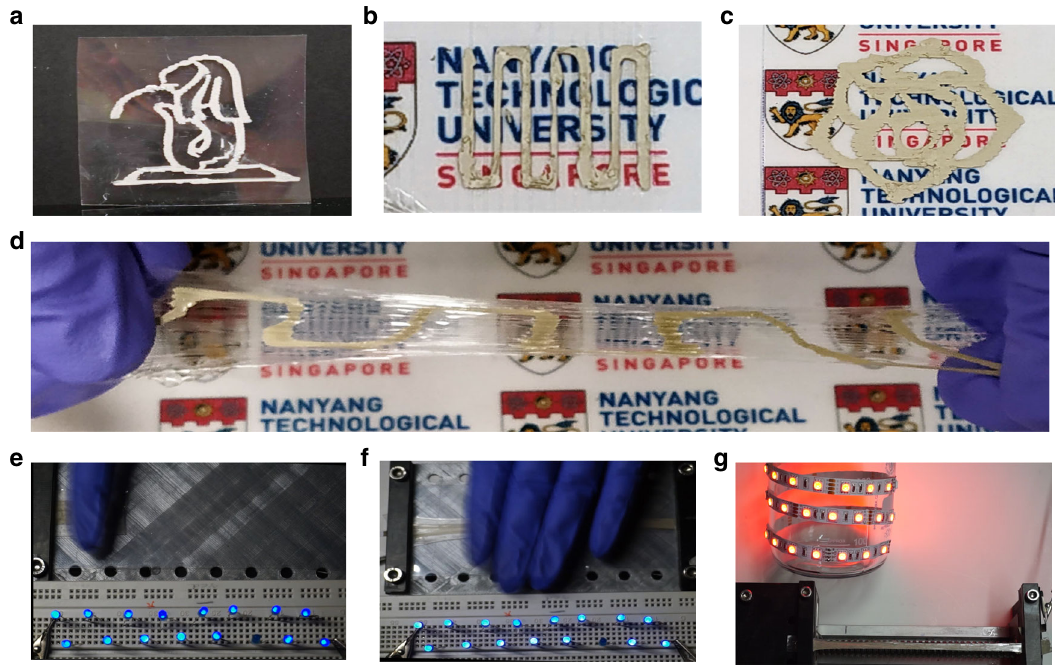
Fig. 5 Digital photos of the 3D printable PUA layer and elastic conductor in various shapes. a Merlion shape. b Serpentine shape. c Flower shape. d Stretched serpentine pattern. e Digital photo of the stretchable and healable triboelectric nanogenerator (SH-TENG) powering light-emitting diodes (LEDs) by fi nger tapping. f Digital photo of the SH-TENG under extreme deformation (2000% axial strain) and powering LEDs by palm tapping. g Digital photo demonstrating the high conductivity of the